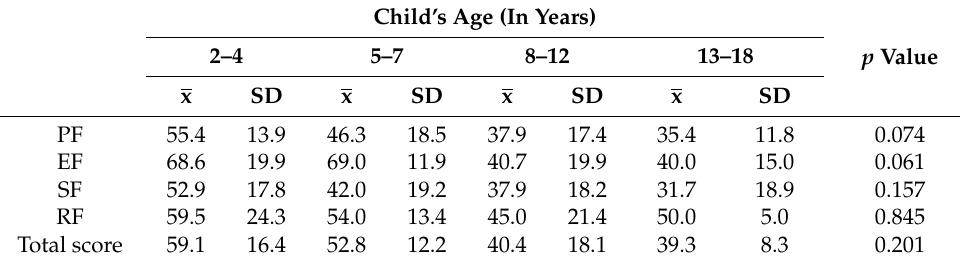
Table 2. PedsQL Generic Core scores by child’s age with PWS.